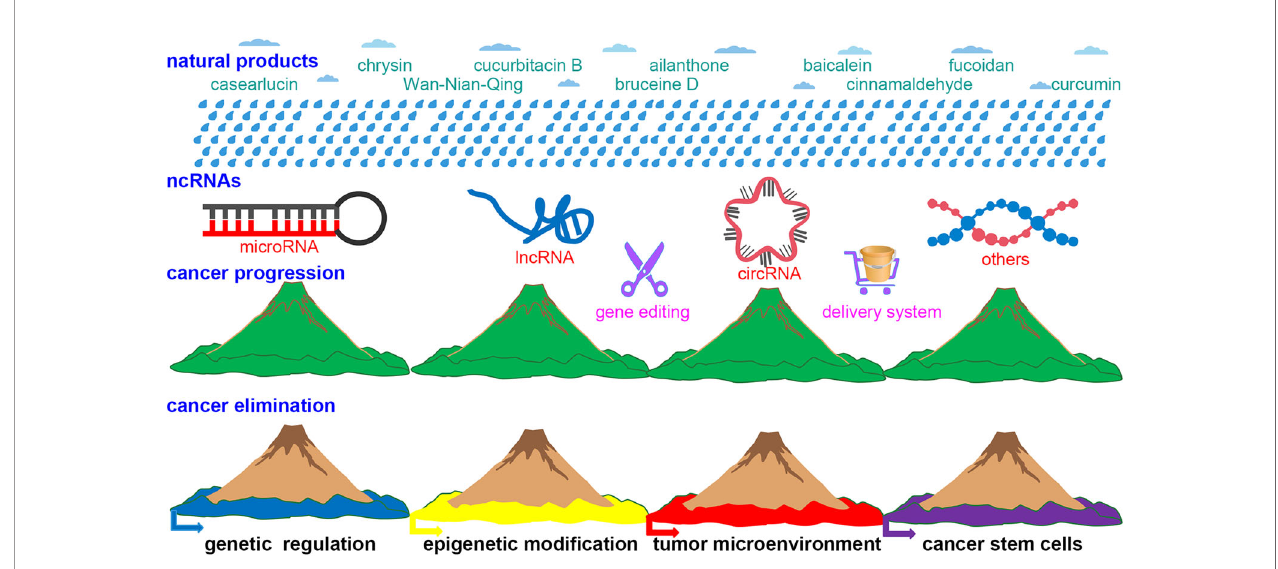
FIGURE 1 | The schematic diagram of this Research Topic. Similar to the phenomenon in which rain with different chemical compositions can alter soil fertility to affect vegetation coverage, natural products with ncRNAs regulation can alter cancer cell survival rates by modulating genetics, epigenetics, the tumor microenvironment, and cancer stem cells. The gene-editing technique (i.e., Crispr/Cas9) and delivery system (i.e., exosomes) can enhance the application of natural products in cancer